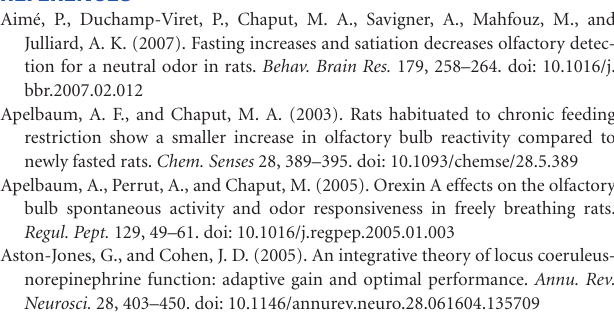
FIGURE 2 | Representation of a hypothetic model according to which OXA terminating in regions such as the OB, LC and amygdala may constitute a pathway for orexinergic modulation of the olfactory memory trace formation underlying COA . The left panel represents the sequence of events that may take place during presentation of a new olfactory CS in the satiated condition. 1a) Olfactory CS induces activation of the OB. 1b) The novelty of the olfactory CS induces LC activation, which results in NA release in the OB and BLA. 2) The olfactory information is transmitted to the BLA where the odor trace is formed pending its association with the US. In the case of a short ISI, this sequence of events results in normal COA. The right panel represents the sequence of events that may take place during presentation of a new